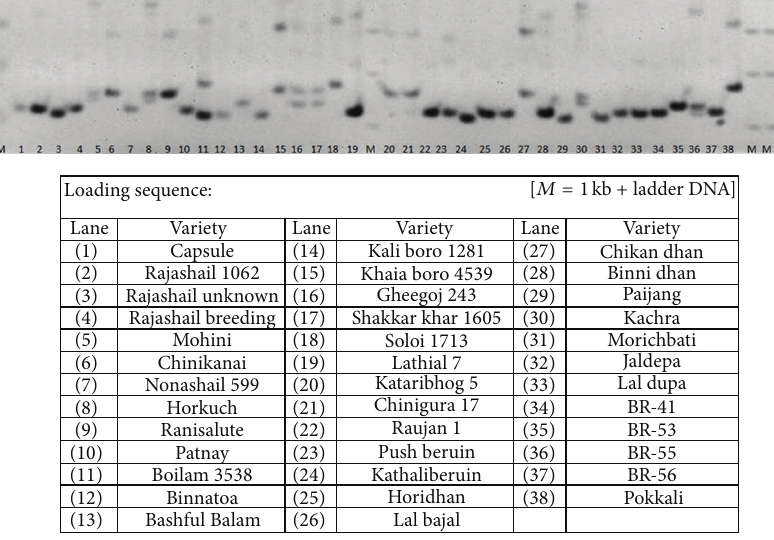
Figure 2: Representative gel showing the polymorphic bands between the varieties. (genotyped with RM7075).